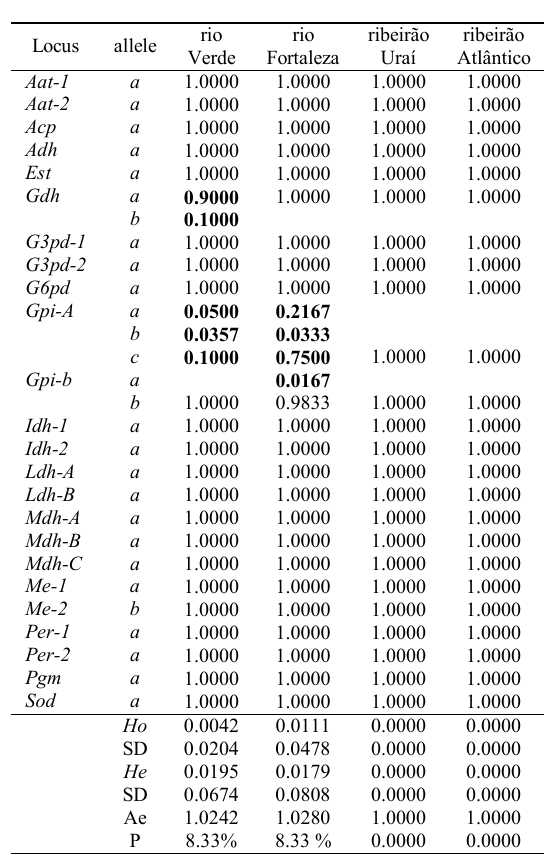
Table 1. Allelic frequencies per locus of Neoplecostomus yapo de from four localities in the rio Paranapanema basin. Polymorphic loci in bold. Ho = observed heterozygosity; He = expected heterozygoisty; SD = standard deviation; Ae= mean number of alleles per locus; P = proportion of polymorphic loci.